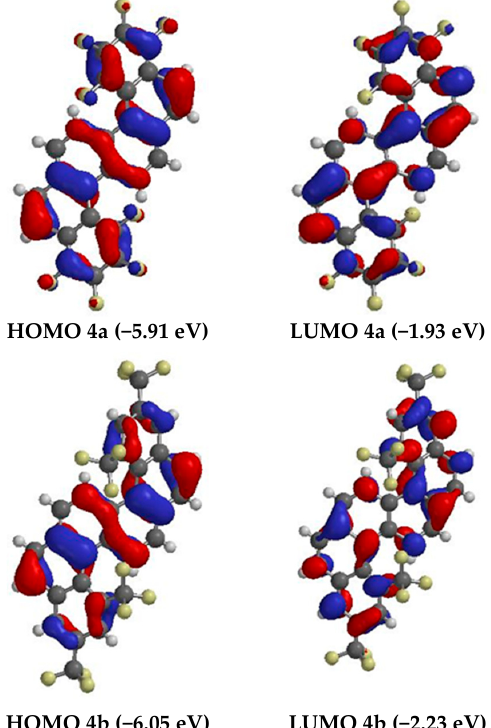
Figure 7. HOMO and LUMO orbitals in the crystals of the compounds 4a and 4b .